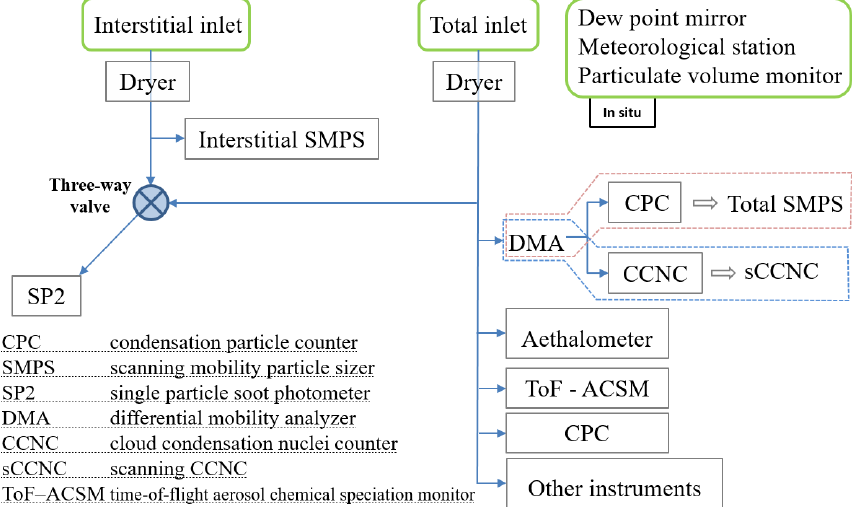
Figure 1. Scheme of the instrumental setup. The SMPS is a DMA–CPC assembly and the sCCNC a DMA-CCNC